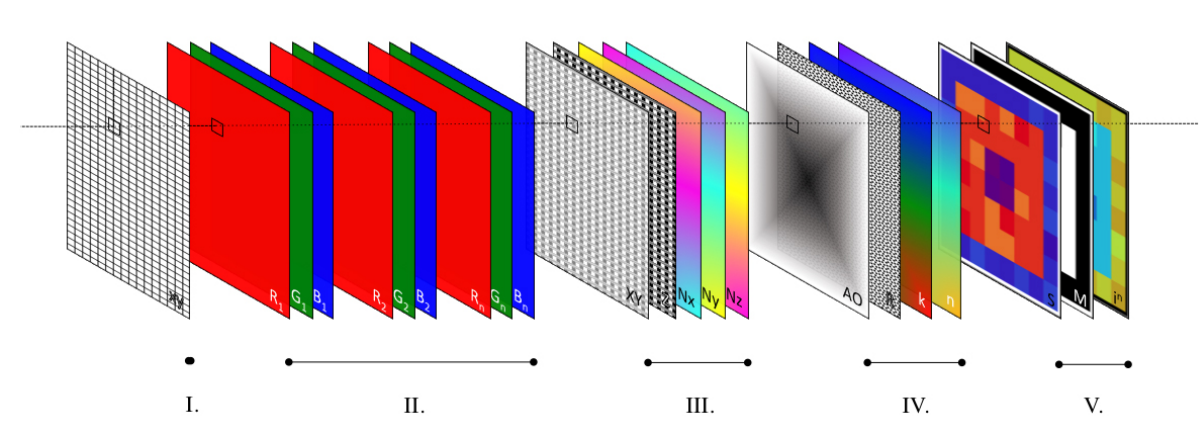
Figure 12: Structure of the multi-layered output: I.) Set the matrix of pixels locations defining the local xy coordinates from the orthophotomosaic. II.) Gather colorimetric information composed of RGB layer for each spectral band (e.g. VIS, IR, UV...) or composite images. III.) Concern geometric information like 3D world space coordinates (X;Y;Z) and points normal (Nx;Ny;Nz). IV.) Store additional features extracted from any 2D or 3D descriptors (n) like Ambient Occlusion (AO), Roughness (R) or Curvatures (k) can be juxtaposed in this section. V.) Enable to complete the data set with other kind of attributes like segmentation methods using Mean Shift/K-Means clusters computed on colorimetric/geometric layers (S), hand-made masks (M) or any relevant analytic combinations